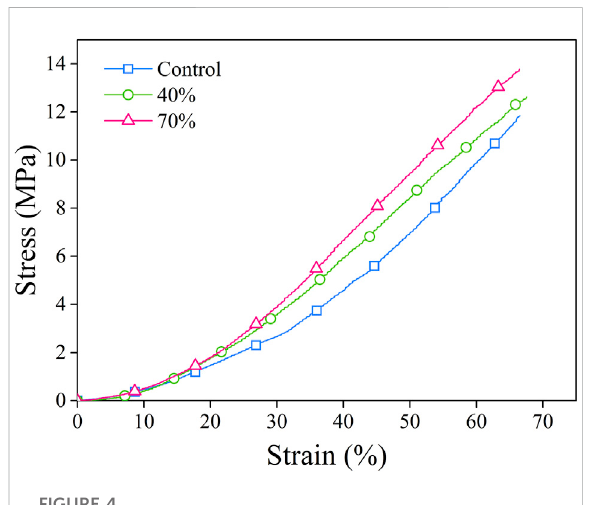
FIGURE 4 Stress – strain curves. The porous composite scaffolds compressed at a strain of (0% – 70%). The cross-head speed was 0.01 mm.s − 1 .